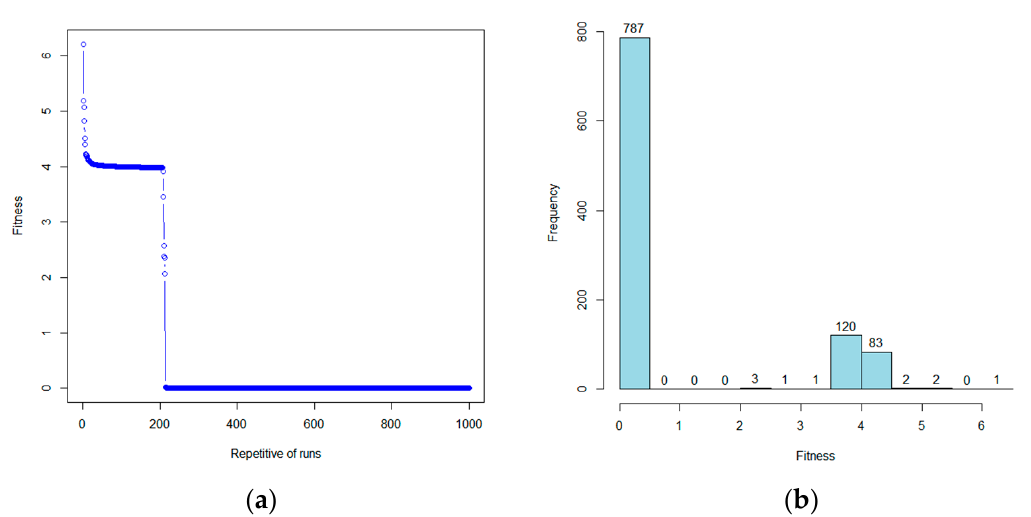
Figure 2. Worst ‐ case analysis with the Rosenbrock (30) function. ( a ) The worst fitness obtained by the CFA program as the number of repetitive runs increases. ( b ) The number of program runs with which each performance level is reached.